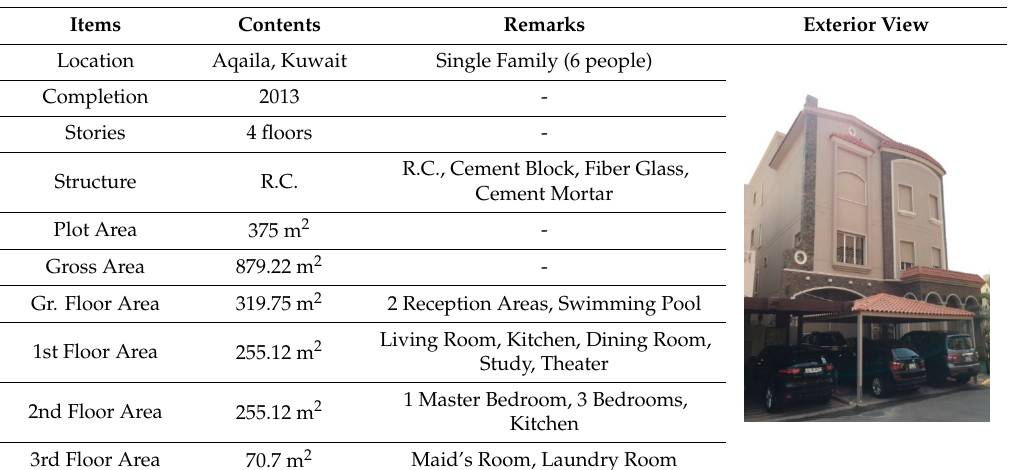
Table 1. Overview of the house to be simulated.